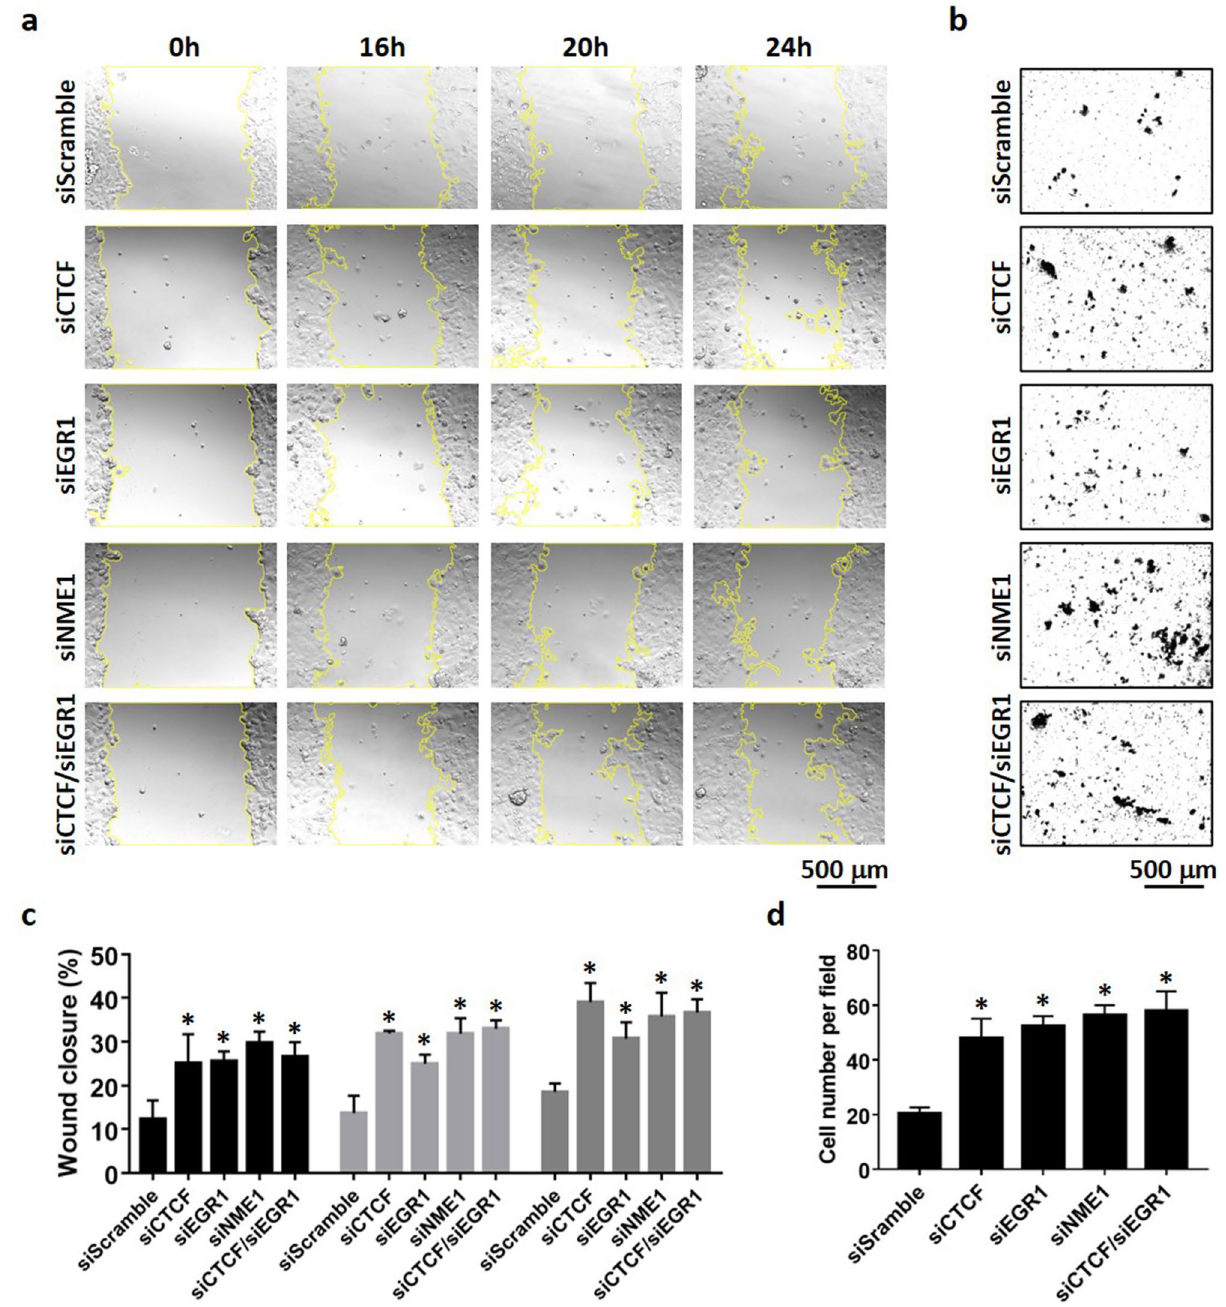
Figure 8. Cell migration of MCF-7 cells upon knockdown of CTCF and EGR1. ( a , c ) Transiently transfected cells were grown to full confluency and scratched with a yellow pipette tip. Photos were taken at different time points with a microscope at ×10 magnification. Cell migration was quantified as percentage of wound closure using ImageJ and MRI Wound Healing Tool plugin. ( b , d ) Transiently transfected cells were seeded into the upper chamber of Transwell inserts and allowed for migration for 48 h. Photos were taken with a microscope at ×10 magnification and the number of migrated cells was quantified using ImageJ. Data represent the mean and standard deviation of three independent trials. *Significance with siScramble, p <